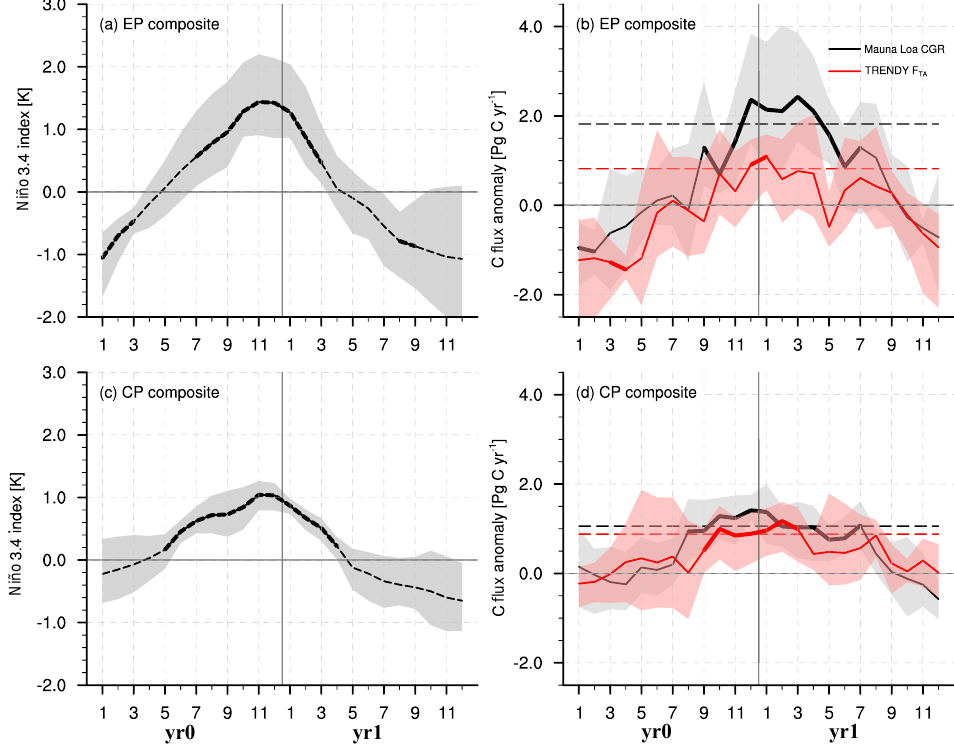
Figure 3. Composites of El Niño and the corresponding carbon flux anomaly (PgCyr − 1 ). (a) The Niño3.4 index composite during EP El Niño events. (b) Corresponding MLO CGR and TRENDY v4 global F TA composite during EP El Niño events. (c) The Nino3.4 index composite during CP El Niño events. (d) Corresponding MLO CGR and TRENDY v4 global F TA composite during CP El Niño events. The shaded area denotes the 95% confidence intervals of the variables in the composite, derived from 1000 bootstrap estimates. The bold lines indicate the significance above the 80% level estimated by the Student’s t test. The black and red dashed lines in (b) and (d) represent the thresholds of the peak duration (75% of the maximum CGR or F TA